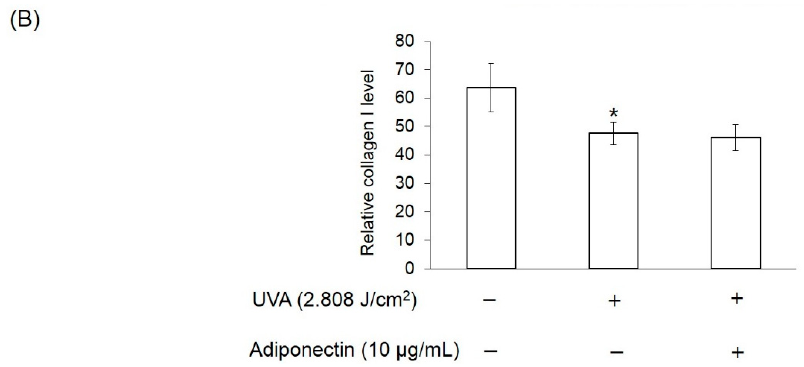
Figure 8. The effect of adiponectin on type I collagen expression in UVA-irradiated Hs68 fibroblasts. ( A ) Immunofluorescence staining of Hs68 fibroblasts using specific type I collagen antibody (×100 magnification, Scale bar = 200 μ m); and ( B ) quantification of immunofluorescence staining of Hs68 fibroblasts. Green fluorescence staining indicates the presence of type I collagen. Blue staining illustrates the DAPI nuclei counterstain. * p < 0.05 with respect to control.